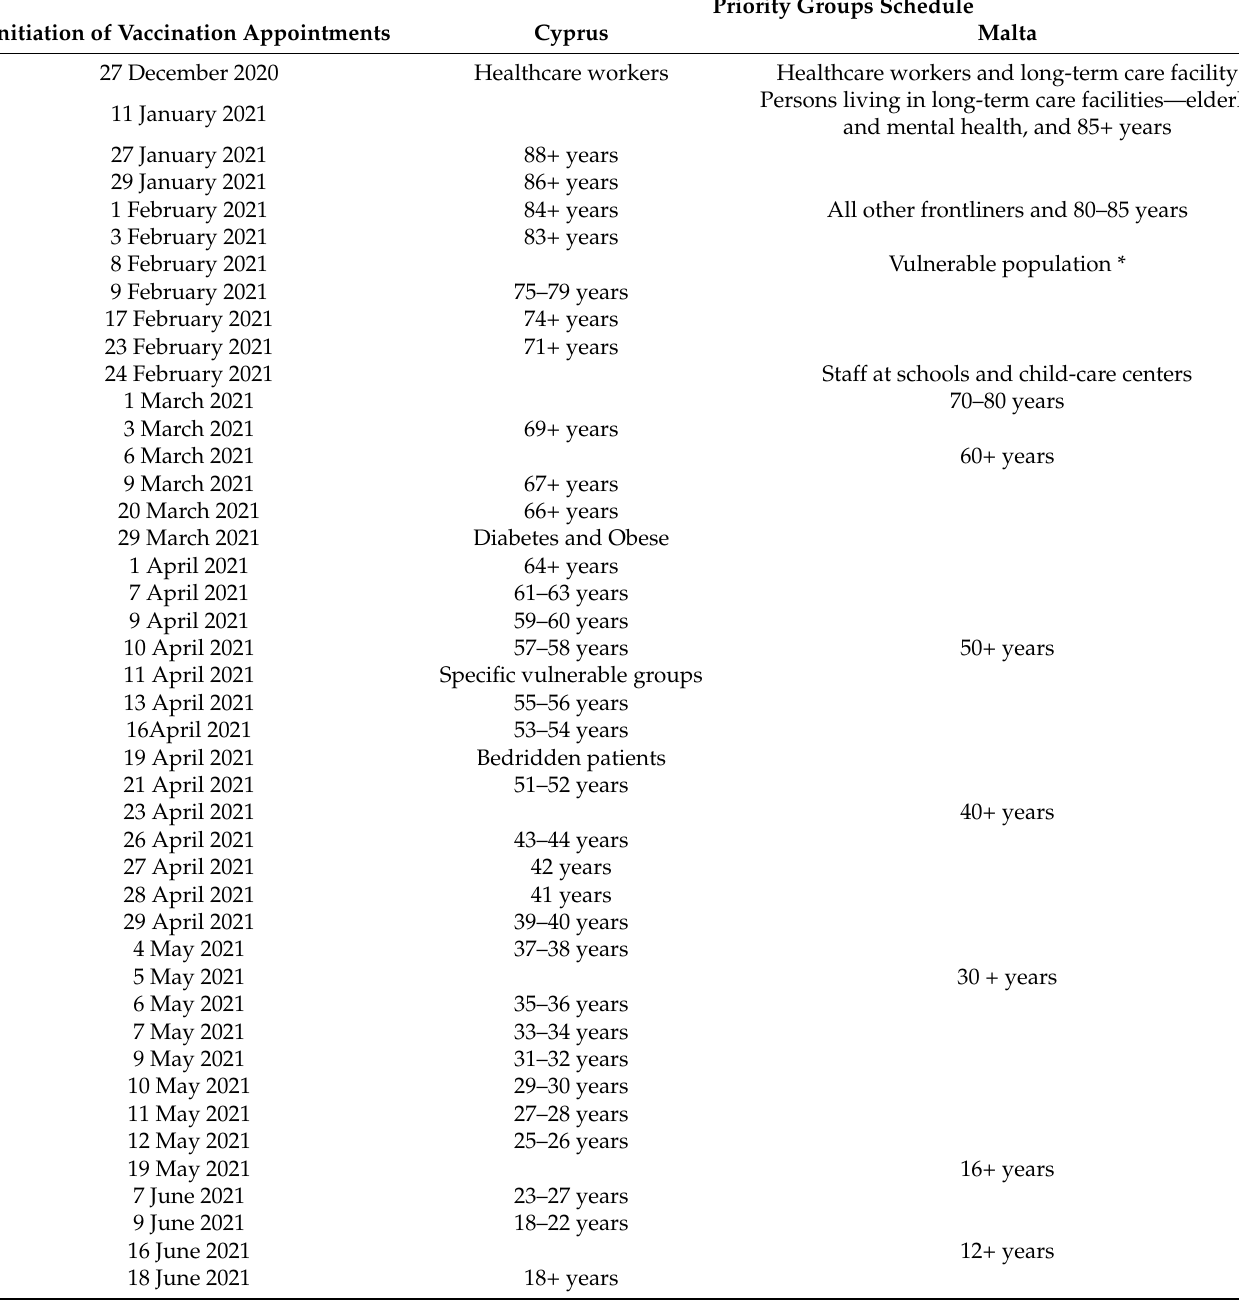
Table 2. Comparisons between Cyprus and Malta for the initiation of vaccination appointment by age